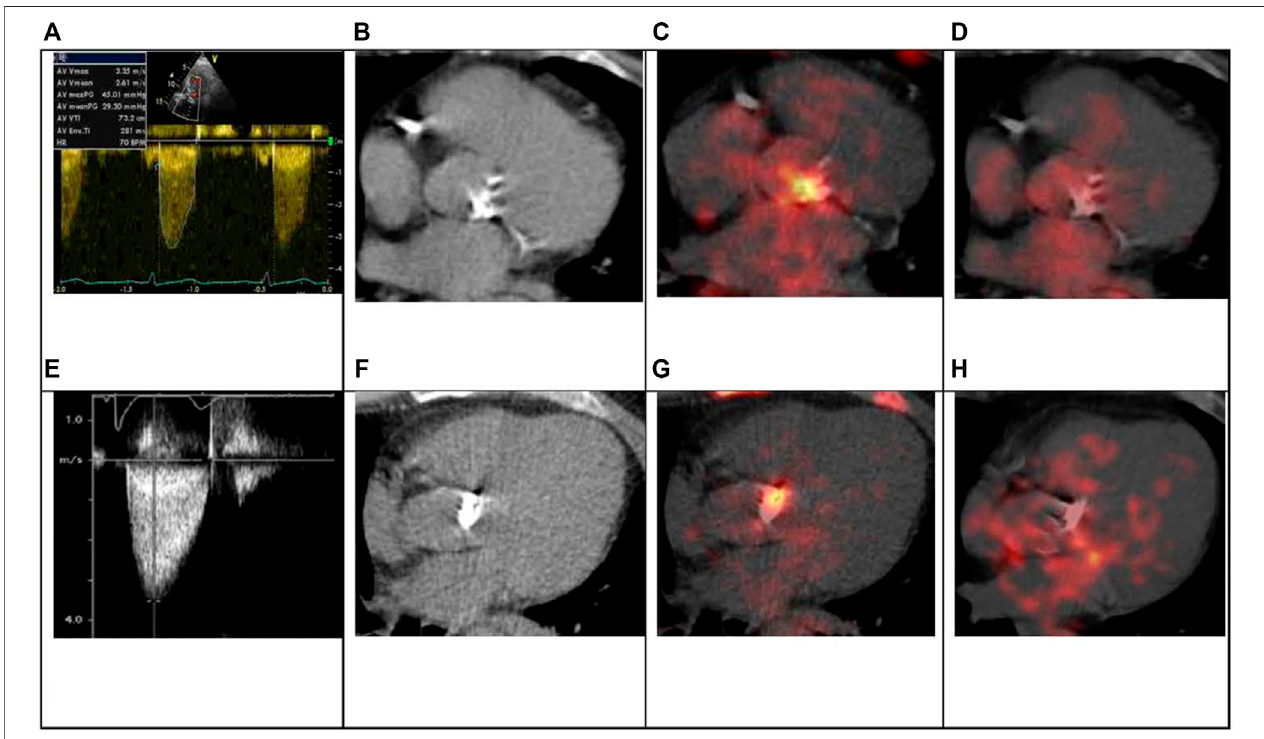
FIGURE 5 | TAV and BAV patient with moderate AS. 64-years old asymptomatic patient with TAV. Echo parameters: Vmax 3.35 m/s, mean gradient 29 mmHg (A) . CT revealed and severe aortic valve calci fi cation: Agatston Score 3139 AU (B) . 18 F-NaF PET/CT demonstrated marked accumulation of the radiotracer: 18 F-NaF TBR max 1.91 (C) . 18 F-FDG valve accumulation was not signi fi cant, 18 F-FDG TBR max 1.05 (D) . 2 years hence symptoms manifested, Vmax increased to 4.2 m/s and aortic valve replacement was performed. 51-years old patient with BAV. Echo parameters: Vmax 3.4 m/s, mean gradient 30 mmHg (E) . CT revealed and severe aortic valve calci fi cation: Agatston Score 4769 AU (F) . 18 F-NaF PET/CT demonstrated signi fi cant accumulation of the radiotracer: 18 F-NaF TBR max 2.58 (G) . 18 F-FDG valve uptake was not increased, 18 F-FDG TBR max 1.17 (H) . There was no clinical or hemodynamic progression registered during 4-years follow